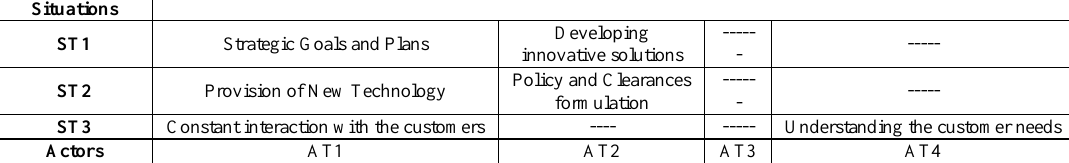
Table 9. Cross interaction interpretive matrix for situation and actors in interpretive form.